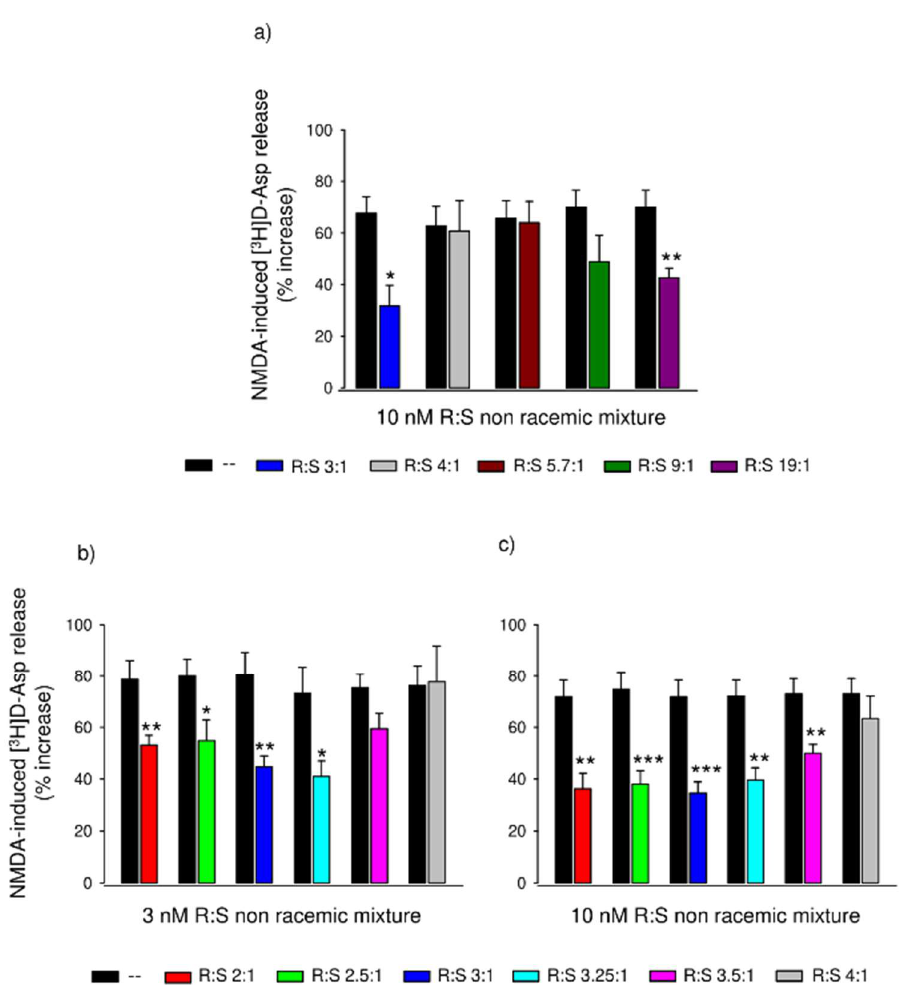
Figure 3. Effects of a series of non-racemic mixtures on the release of [ 3 H]D-Asp induced by NMDA in rat spinal cord synaptosomes in superfusion. ( a ) effects of 10 nM non-racemic R/S mixtures ranging from 3:1 to 19:1; ( b ) effect of 3 nM non-racemic R/S mixtures ranging from 2:1 to 4:1 and ( c ) effect of 10 nM non-racemic R/S mixtures ranging from 2:1 to 4:1. Synaptosomes were labeled with the radioactive tracer, layered on microporous filters, and superfused as described under the Materials and Methods section. Results are expressed as percent increase in [ 3 H]D-Asp release over basal efflux. Data are means ± S.E.M. of 3–9 experiments run triplicate (three superfusion units for each experimental condition). * p < 0.05, ** p < 0.01, *** p < 0.001, when compared to the respective NMDA control (two-tailed Student’s t-test).